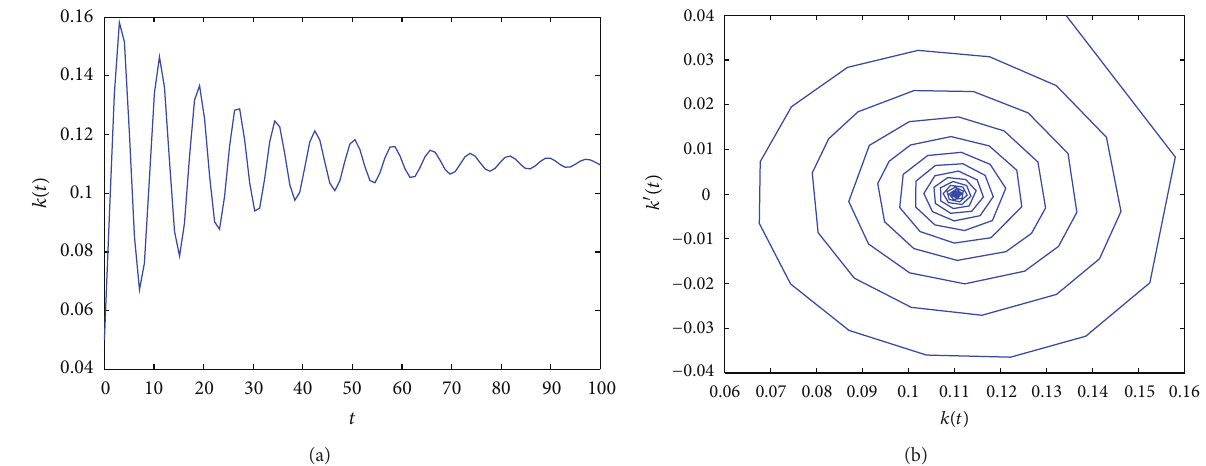
Figure 1: The time evolution of the function 𝑘(𝑡) for 𝑠 = 0.11 , 𝛿 = 0.8 , 𝛼 = 0.1 , 𝐴 = 1 , 𝜏 1 = 3 , and 𝜏 2 = 2 (a). The 𝑘 󸀠 (𝑡) versus 𝑘(𝑡) , for 𝑡 ∈ [0, 100] (b).